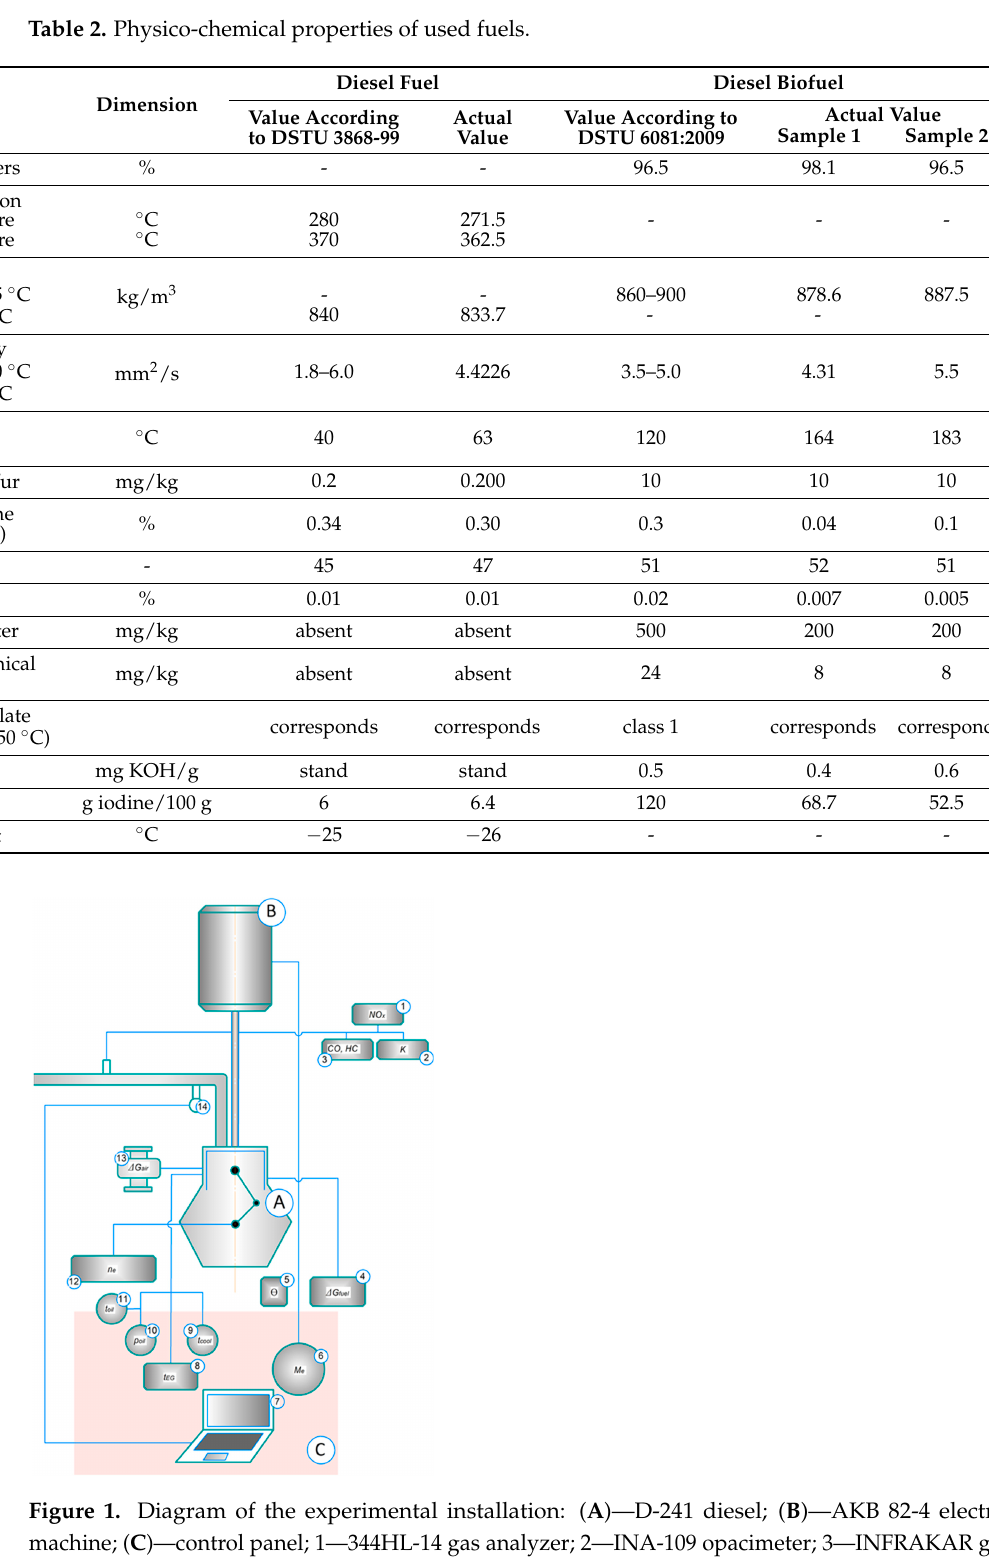
vices. Table 3. Measurement errors of devices and equipment Physico. Measured Quantity